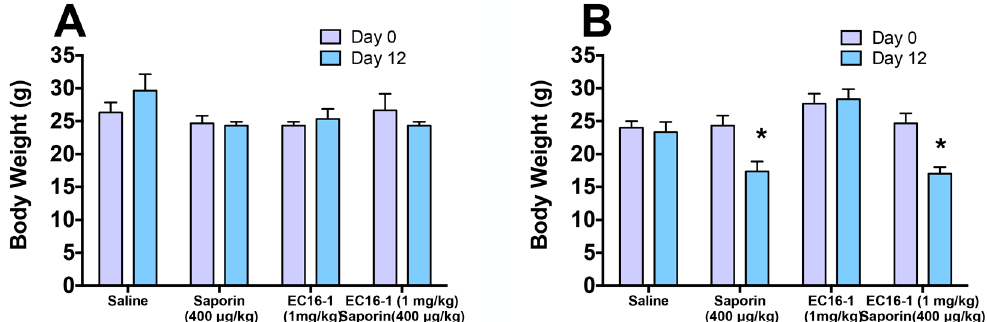
Figure 8. Effect of EC16-1/saporin on the body weight of animals bearing parental and ABCB1 or ABCG2 tumors. The changes in the mean body weight of mice ( n = 6) bearing SW620 and SW620/AD300 tumors ( A ) and the changes in the mean body weight of mice ( n = 6) bearing NCI-H460 and NCI-H460/MX20 tumors ( B ). The changes in the body weight are plotted for day 0 (before) and day 12 (after) of the treatment. The bar graphs represent the mean body weight and the error bars represent the SD. * p < 0.05 compared with day 0.